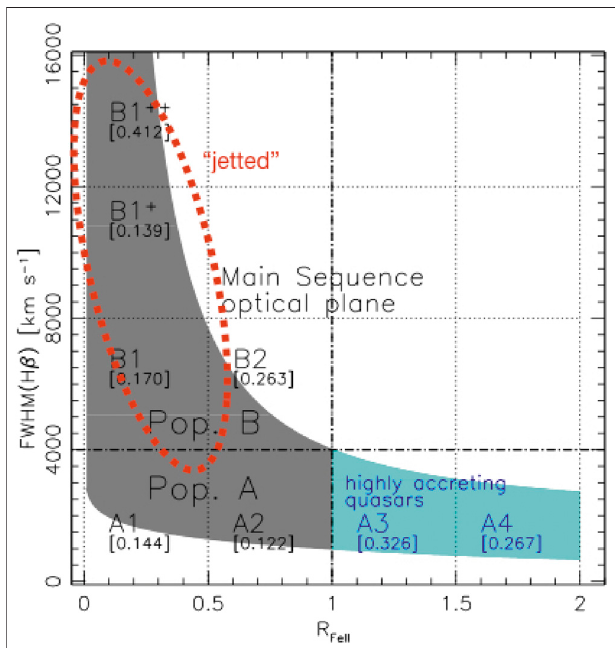
FIGURE 12 | The optical plane of the quasar main sequence with the occupation accounted for by the combined effect of Eddington ratio and orientation, as claimed byShen and Ho (2014).The two grids werecomputed for M BH (cid:1) 10 8 M 0 and10 9 M 0 (gray),forseveralvaluesof L / L Edd andfor viewing angle θ between 0 and 40 ° , following the toy model described in the text and in more detail in Ref. (Marziani et al., 2018). In the left panel, the labels identify the areas of Population A and B (respectively below and above the FWHM limit at 4,000 km s − 1 ), and of extreme Population A ( R FeII ≳